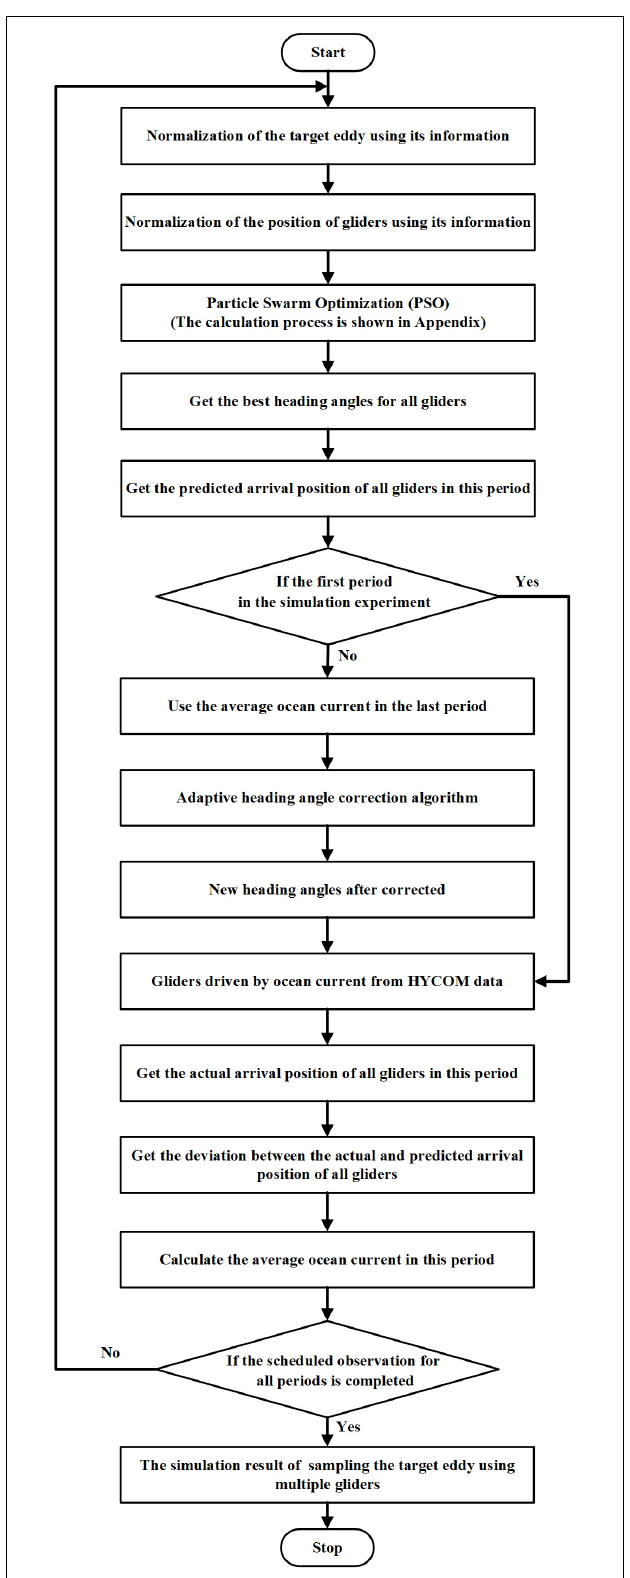
FIGURE 4 | The flow chart of the simulation